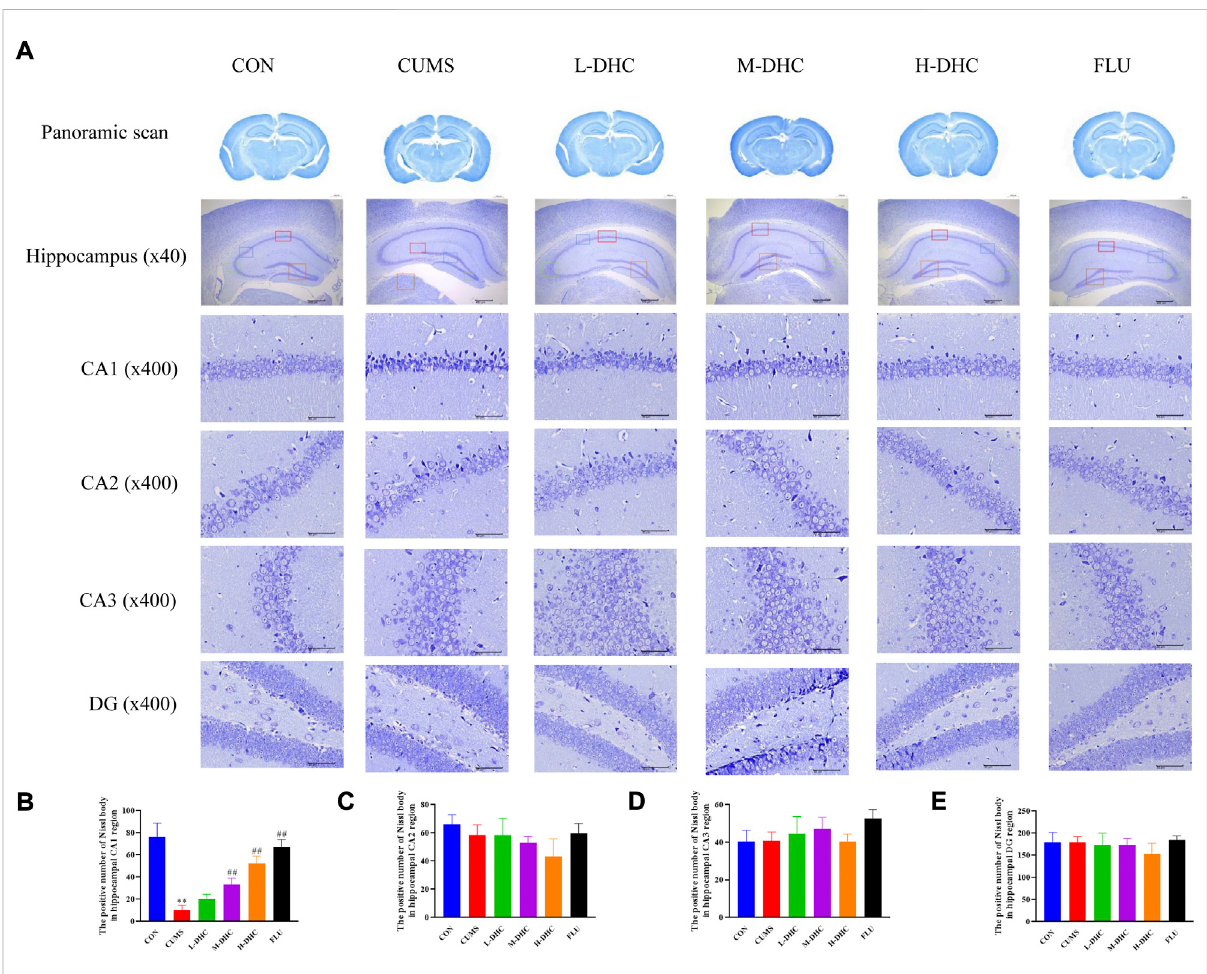
FIGURE 3 Effects of DHC or fl uoxetine on the damage of hippocampus neurons in CUMS-induced depression in mice. (A) Representative images of Nissl staining ofthe hippocampalregion. Previouslymentioned is apanoramic scan ofbrain tissue after Nissl staining;thefollowing image isNissl staining of the CA1, CA2, CA3, and DG regions of the hippocampus, ×400 magni fi cation (scale bar 50 μ m). The red box represents the CA1 region, the blue box represents the CA2 region, the green box represents the CA3 region, and the orange represents the DG region; (B) the positive number of NisslbodyinthehippocampalCA1regionofmiceineachgroup; (C) thepositivenumberofNisslbodyinthehippocampalCA2regionofmiceineach group; (D) the positive number of Nissl body in the hippocampal CA3 region of mice in each group; (E) the positive number of Nissl body in the hippocampal DG region of mice in each group. ** p < 0.01, compared with the control (CON) group; ## p < 0.01, compared with the CUMS